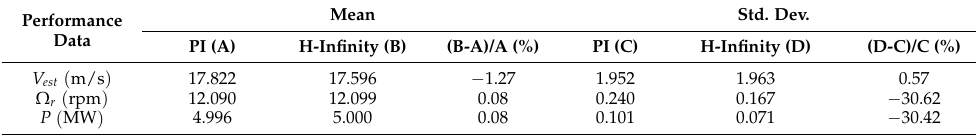
Table 5. Comparison of NTM results for performance data in 18 m/s noisy environment. Perfor-